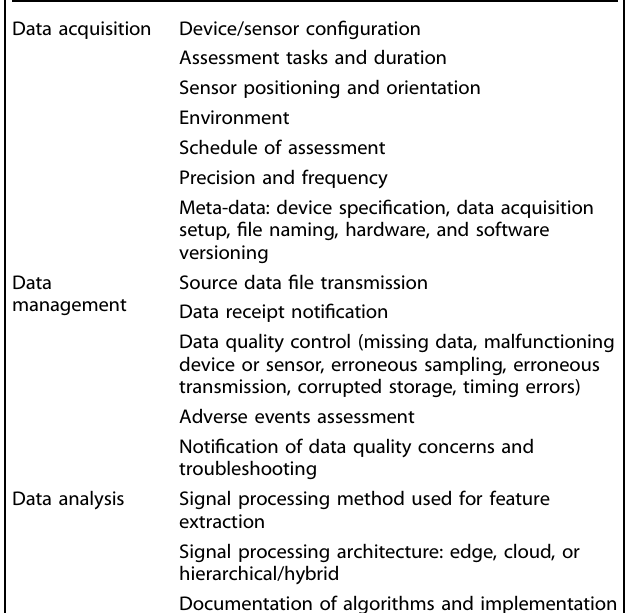
Table 2. Mapping SoVs across different measurement process